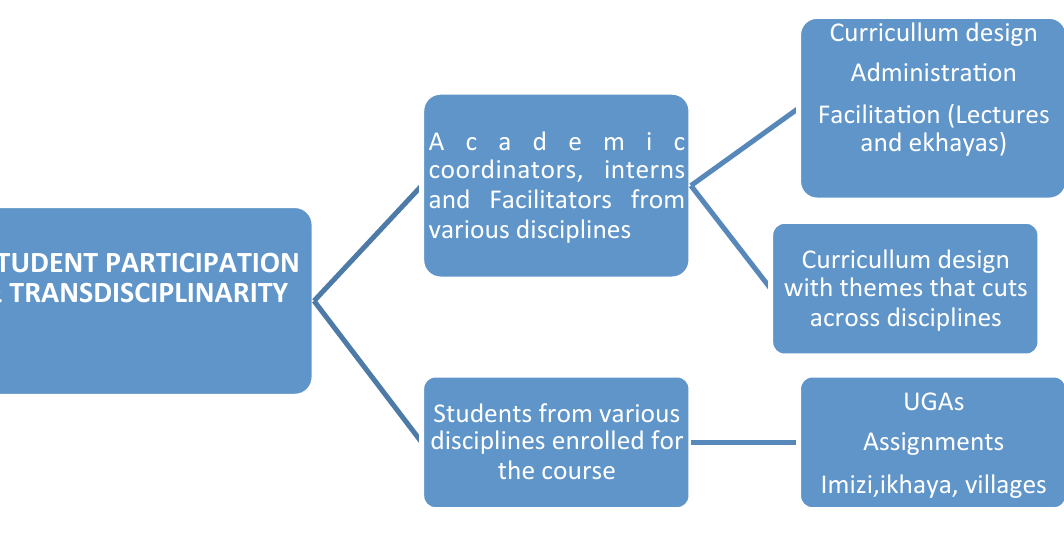
Figure 1: Student Participation and transdisciplinarity in the Centre for Transdisciplinary Studies Department University of Fort Hare (Garutsa,